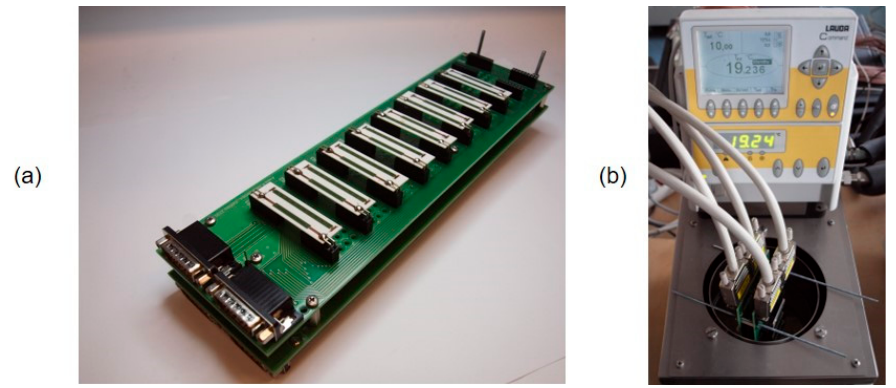
Figure 2. ( a ) Measurement tool for multiple measurement of resistors and ( b ) measurement tool in the thermostatic bath.